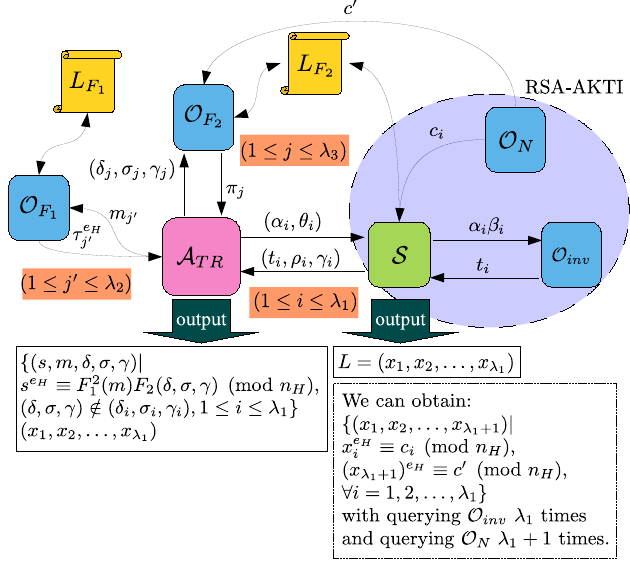
Figure 8. The model of the proof for Tamper